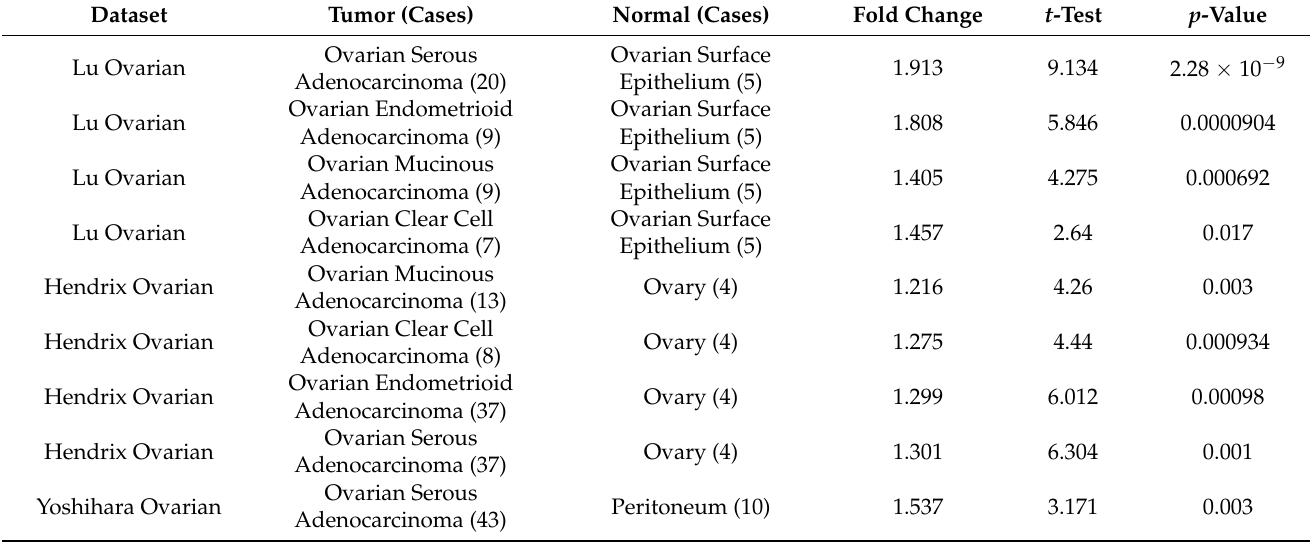
Figure 3. The differential expression analysis and ROC analysis of PUS7 in OV and normal tissues. ( A , B ) The expression analysis of PUS7 in TCGA and GSE18520 cohorts, respectively. ( C , D ) The ROC analysis of PUS7 between OV and normal samples in TCGA and GSE18520 cohorts. AUC is plotted as sensitivity% vs. 100-specificity%. A p < 0.05 was considered a significant difference. Table 1. The comparison analysis of PUS7 in ovarian cancer and normal tissue in different cohorts (Oncomine).